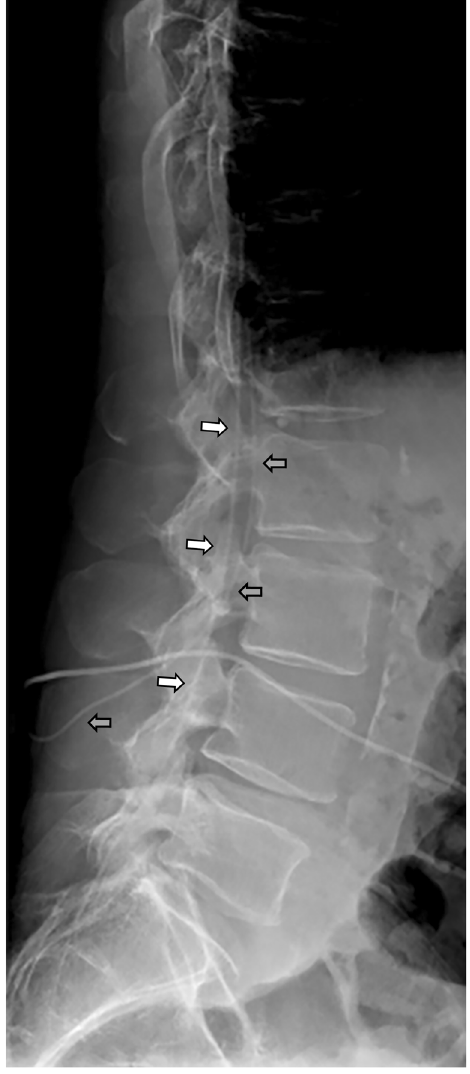
Fig. 11 A 62-year-old man with treatment-resistant spasticity was suc- cessfully treated for many years with intrathecal baclofen. During exac- erbation of the clinical symptomatology, the catheter 8731SC was found to be torn off and left behind in the spinal canal (white arrow). For further treatment, a new catheter, of the same type was inserted ( gray arrow